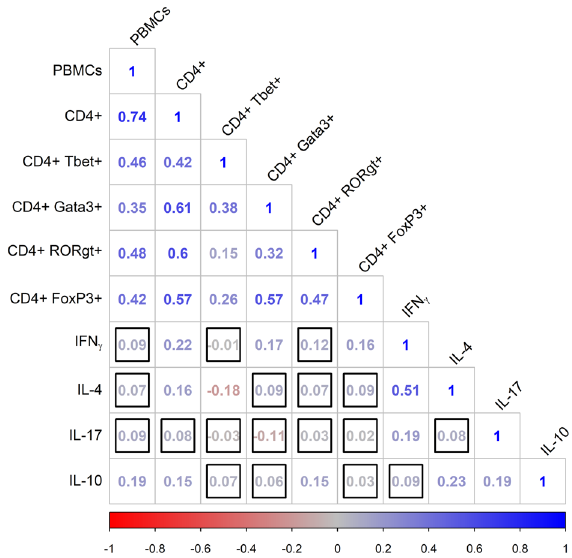
Figure 2. Correlation matrix showing Spearman’s rank correlations between pairs of immunological variables corrected for age and sex, where redder values indicate increasingly negative associations and bluer values indicate increasingly positive associations. Cell phenotypes represent cell counts per ml blood. Correlations outlined with a black square were not statistically significant at α =